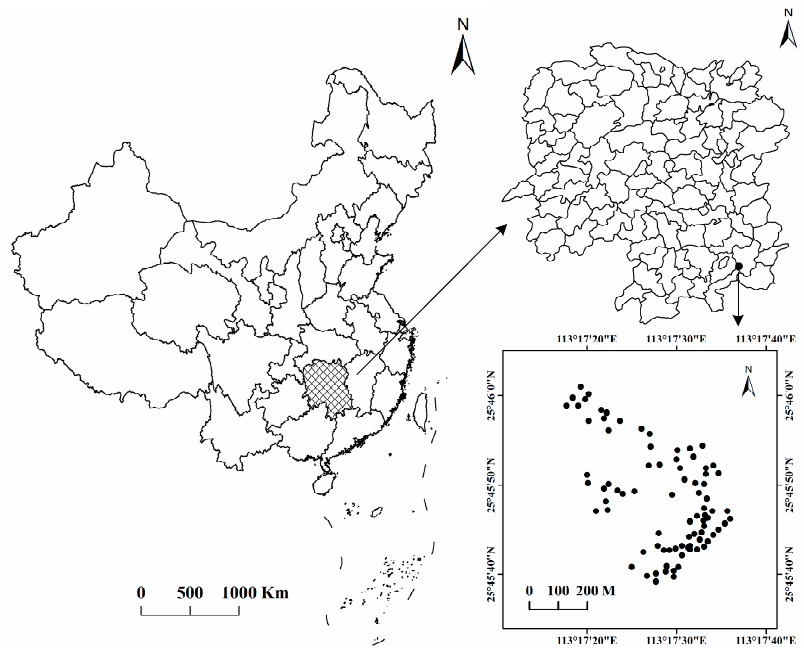
Figure 1. Study area and sampling points.